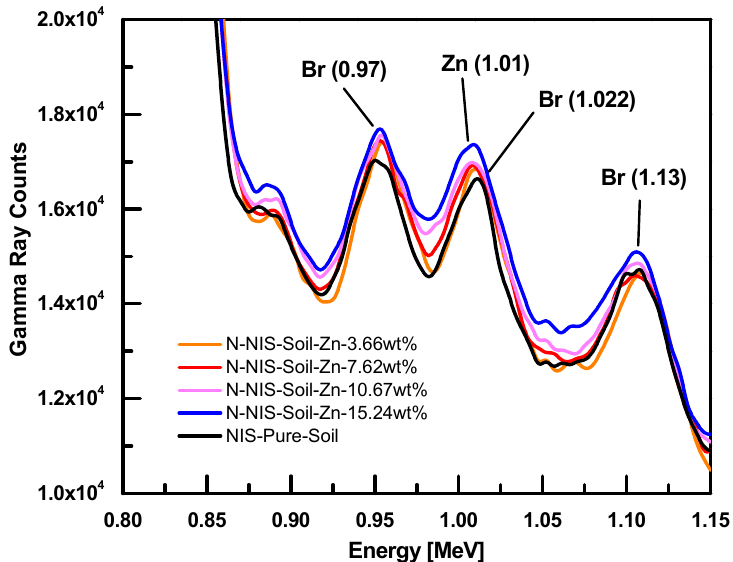
Figure 5. Prompt gamma-ray spectra were acquired by the CeBr 3 detector, obtained from the background spectrum and superimposed upon four samples containing zinc with the following concentrations, 3.66, 7.62, 10.67, and 15.24 wt%.